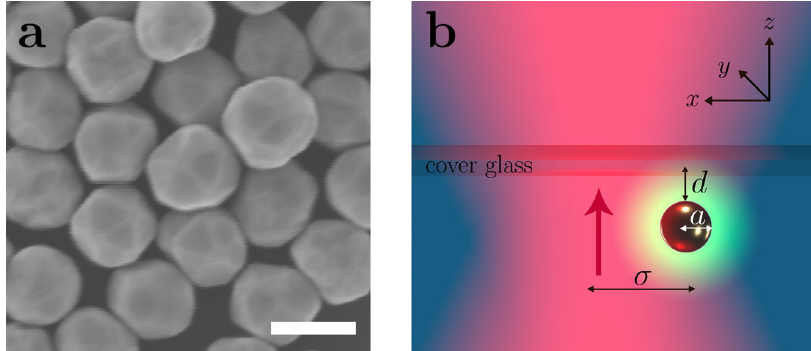
Fig. 1 Nanoparticles and their driving mechanism. a SEM image of the gold nanoparticles employed in this work. From this image, it can be appreciated how they are approximately spherical, but also feature characteristic crystalline facets. The scale bar is 150 nm. b A nanoparticle (radius a ) is trapped in a harmonic potential by a focused laser beam (magenta shading, propagating upwards in the direction of the red arrow, beam width σ ). The particle is con fi ned in a quasi-two-dimensional space in the xy -plane near the sample upper cover glass at distance d by the competing effects of the optical scattering force and the electrostatic repulsion by the glass. Depending on its distance from the trap center, the nanoparticle is irradiated by different intensities and, therefore, reaches different temperatures T . If T exceeds the critical temperature T c , a concentration gradient is locally induced around the nanoparticle (green ring surrounding the particle), thereby leading to a drift velocity away from the trap ’ s